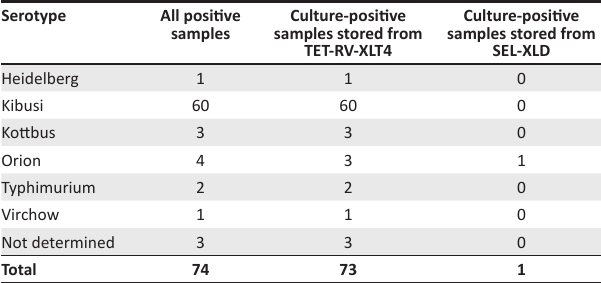
TABLE 1: Serotypes of Salmonella enterica subsp. enterica obtained.